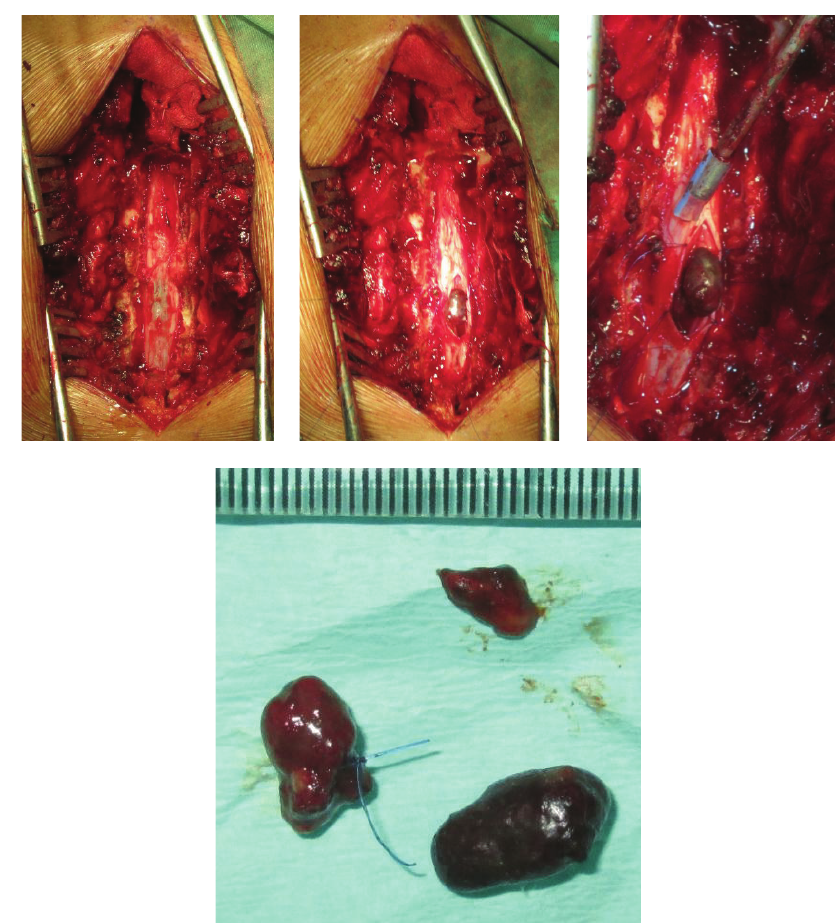
Figure 3: Surgical exposure and gross pathology of the tumor showing well-defined tubular lesion with dark-red